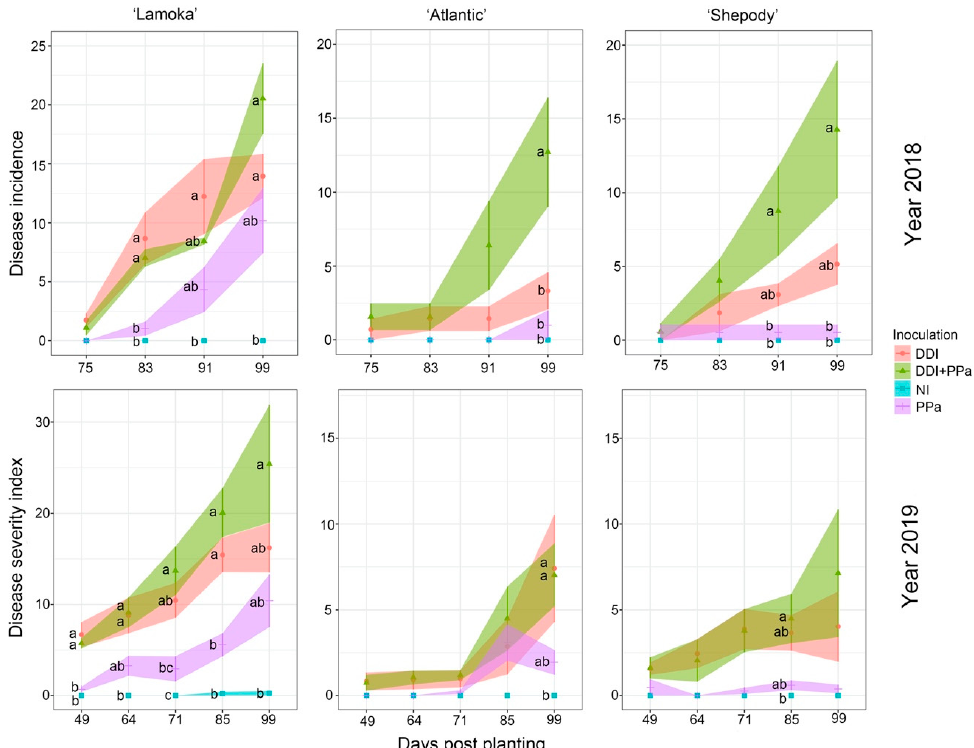
Figure 3. Disease progress of blackleg in potato “Lamoka”, “Atlantic” and “Shepody” grown from seed pieces inoculated with either Dickeya dianthicola (DDi), Pectobacterium parmentieri (PPa), or DDi + PPa under field conditions in 2018 ( upper panels ) and 2019 ( bottom panels ). Non-inoculated (NI) plants were used for control. Disease incidence or disease severity index was analyzed using the ANOVA procedure with Tukey’s multiple range test at a significance level α = 0.05. Mean values at same day point with different letters were significantly different ( p < 0.05).